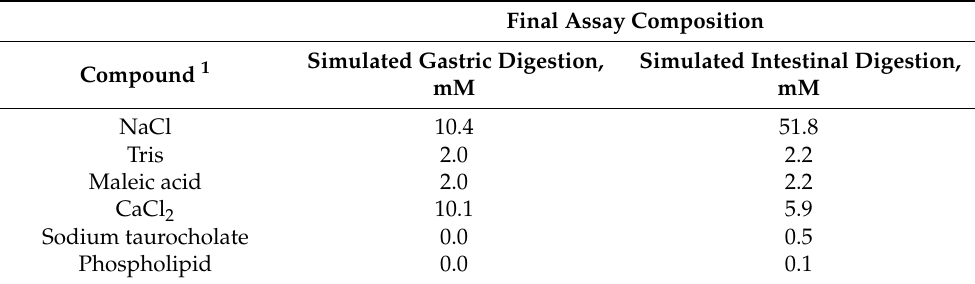
Table 2. Final in vitro gastric- and intestinal digestion assay concentrations (mM). The contribution of CaCl 2 and NaCl from the emulsions is included in the shown